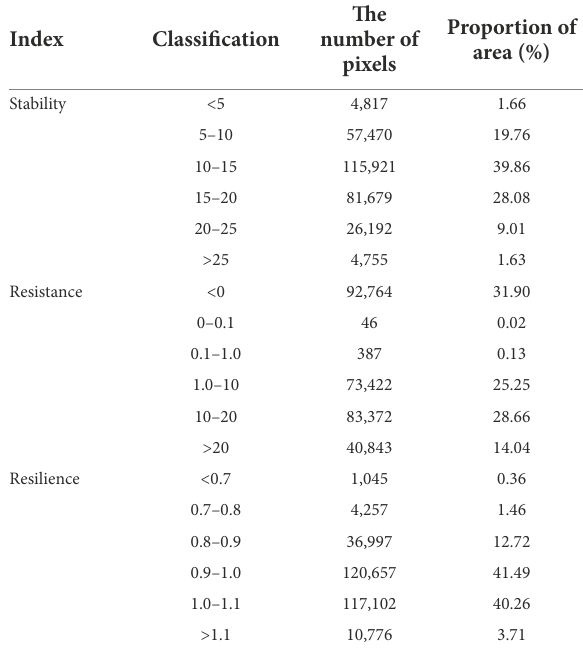
TABLE 3 The spatial area percentage of stability, resistance, and